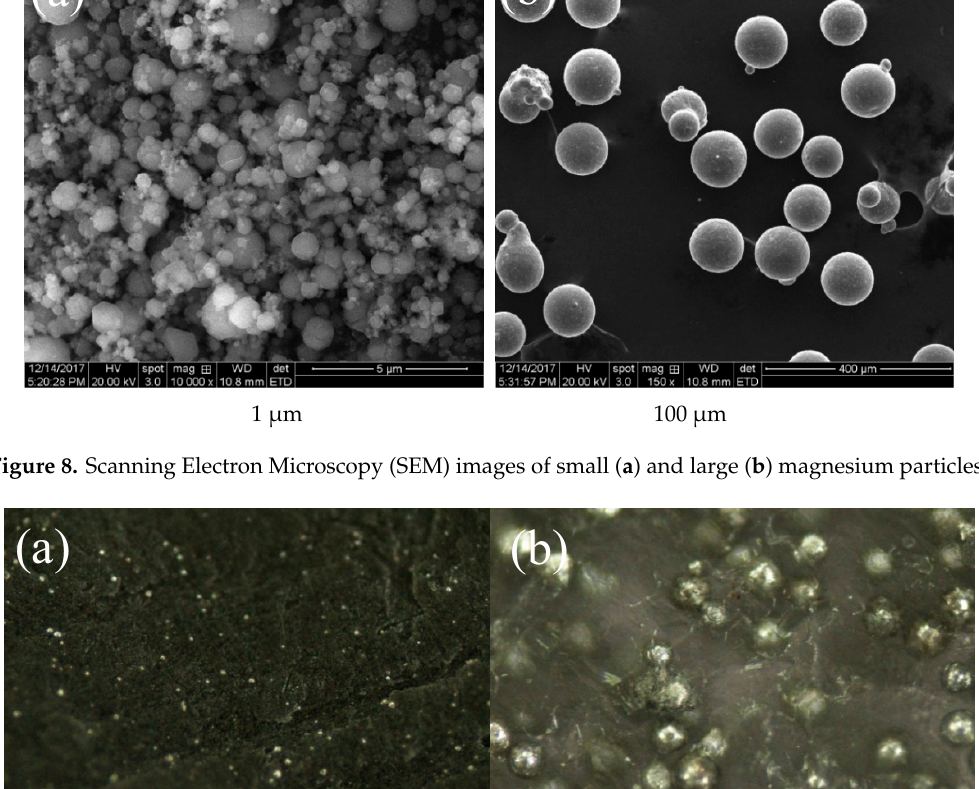
shows high energy.